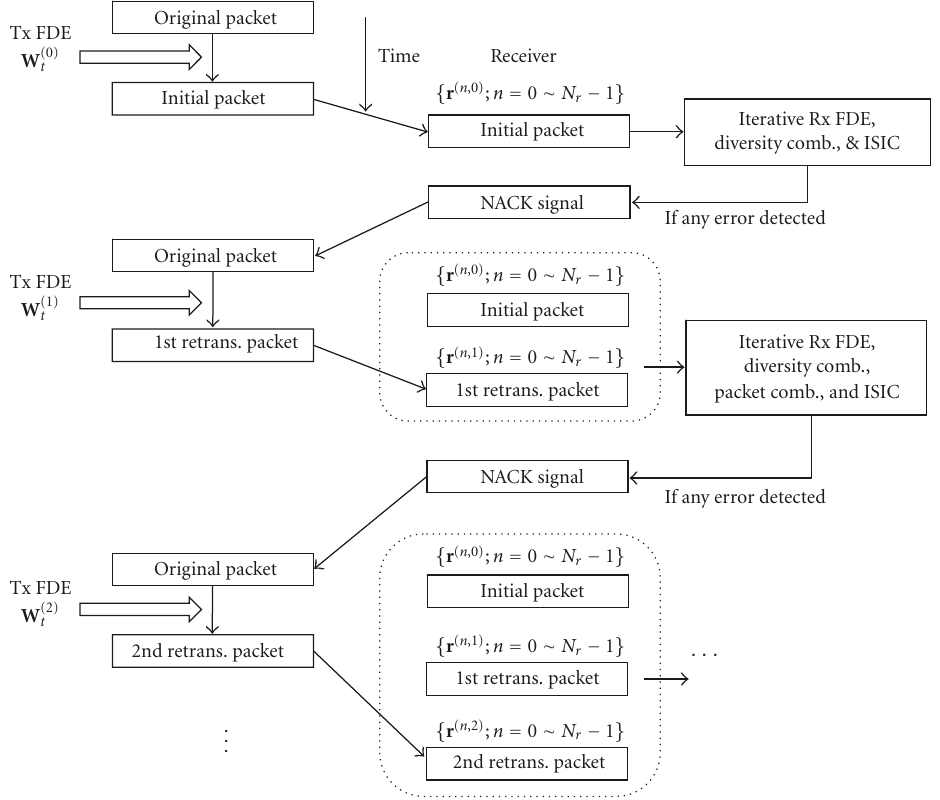
Figure 1: SC-HARQ using joint iterative Tx/Rx MMSE-FDE and